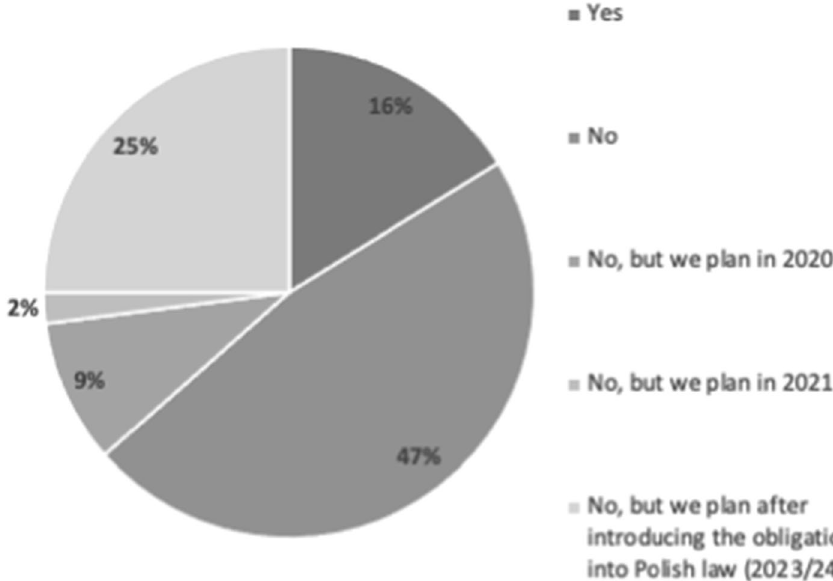
Fig. 3 Distribution of answers